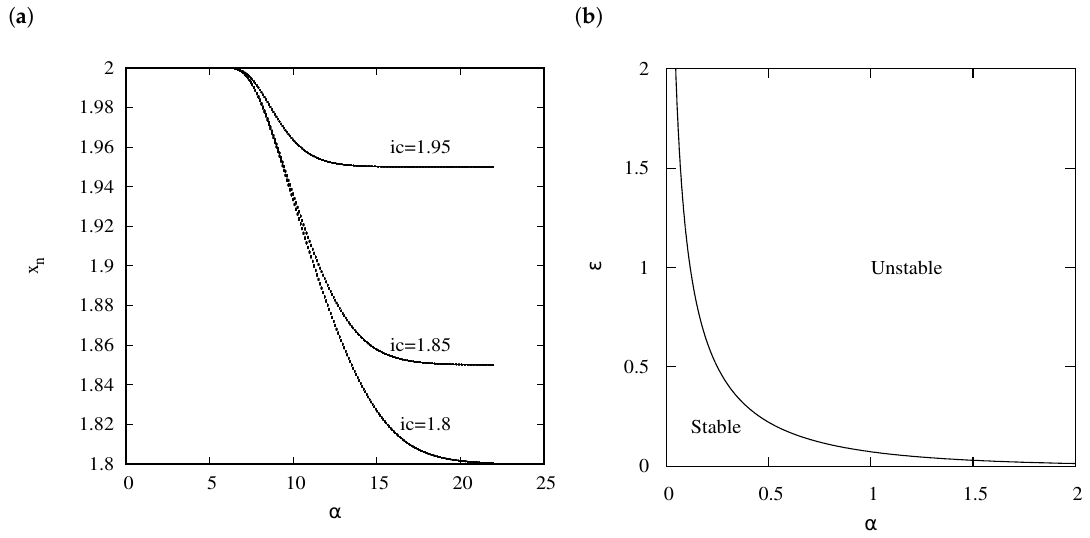
Figure 1. (a) Bifurcation diagram for the unperturbed system (b) Regions of stability and instability for the perturbed